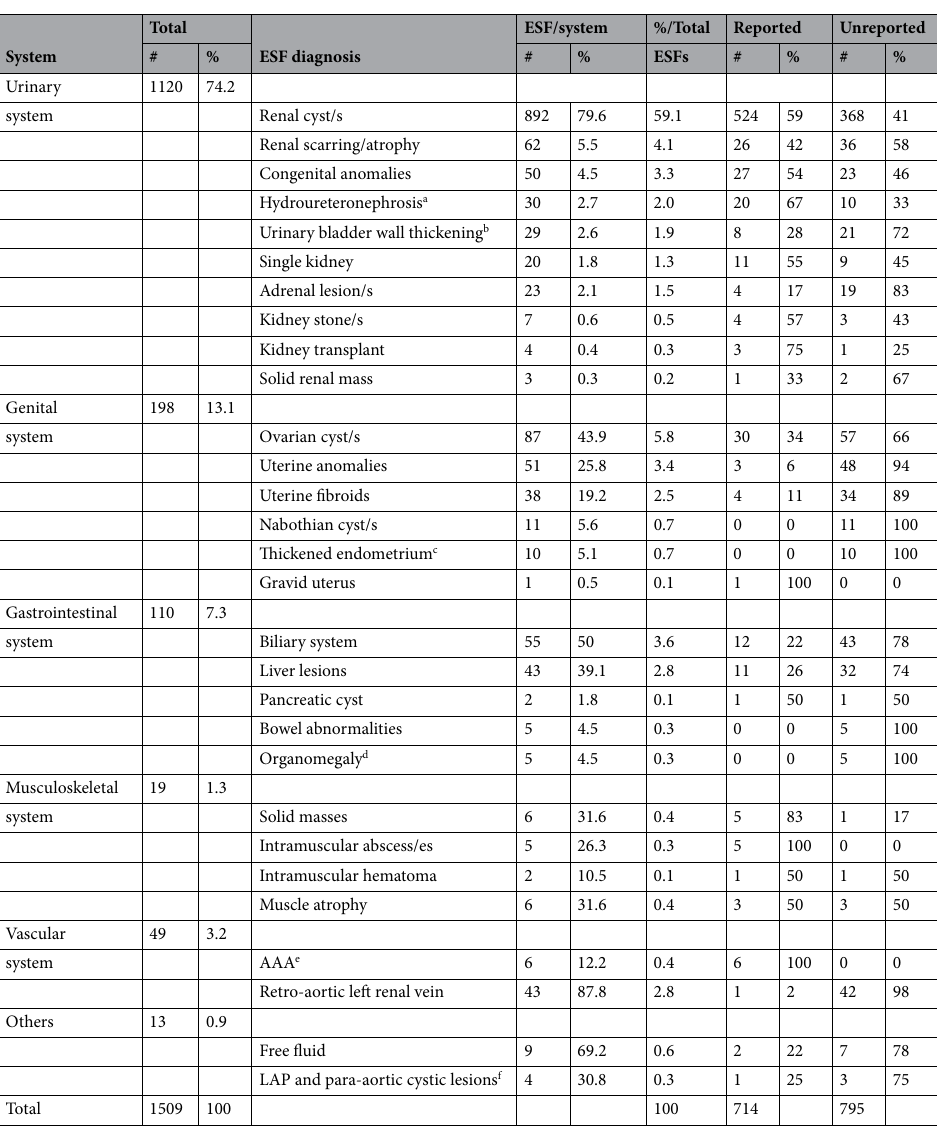
Table 1. The distribution of Extraspinal Findings according to the involved systems and diagnosis. # Number, % percentage, ESF extraspinal finding. a Abnormal distension of the calyces as graded per the Society of Fetal Urology (SFU). b Thickness > 3 mm from its outer to inner borders in fully distended status as assessed